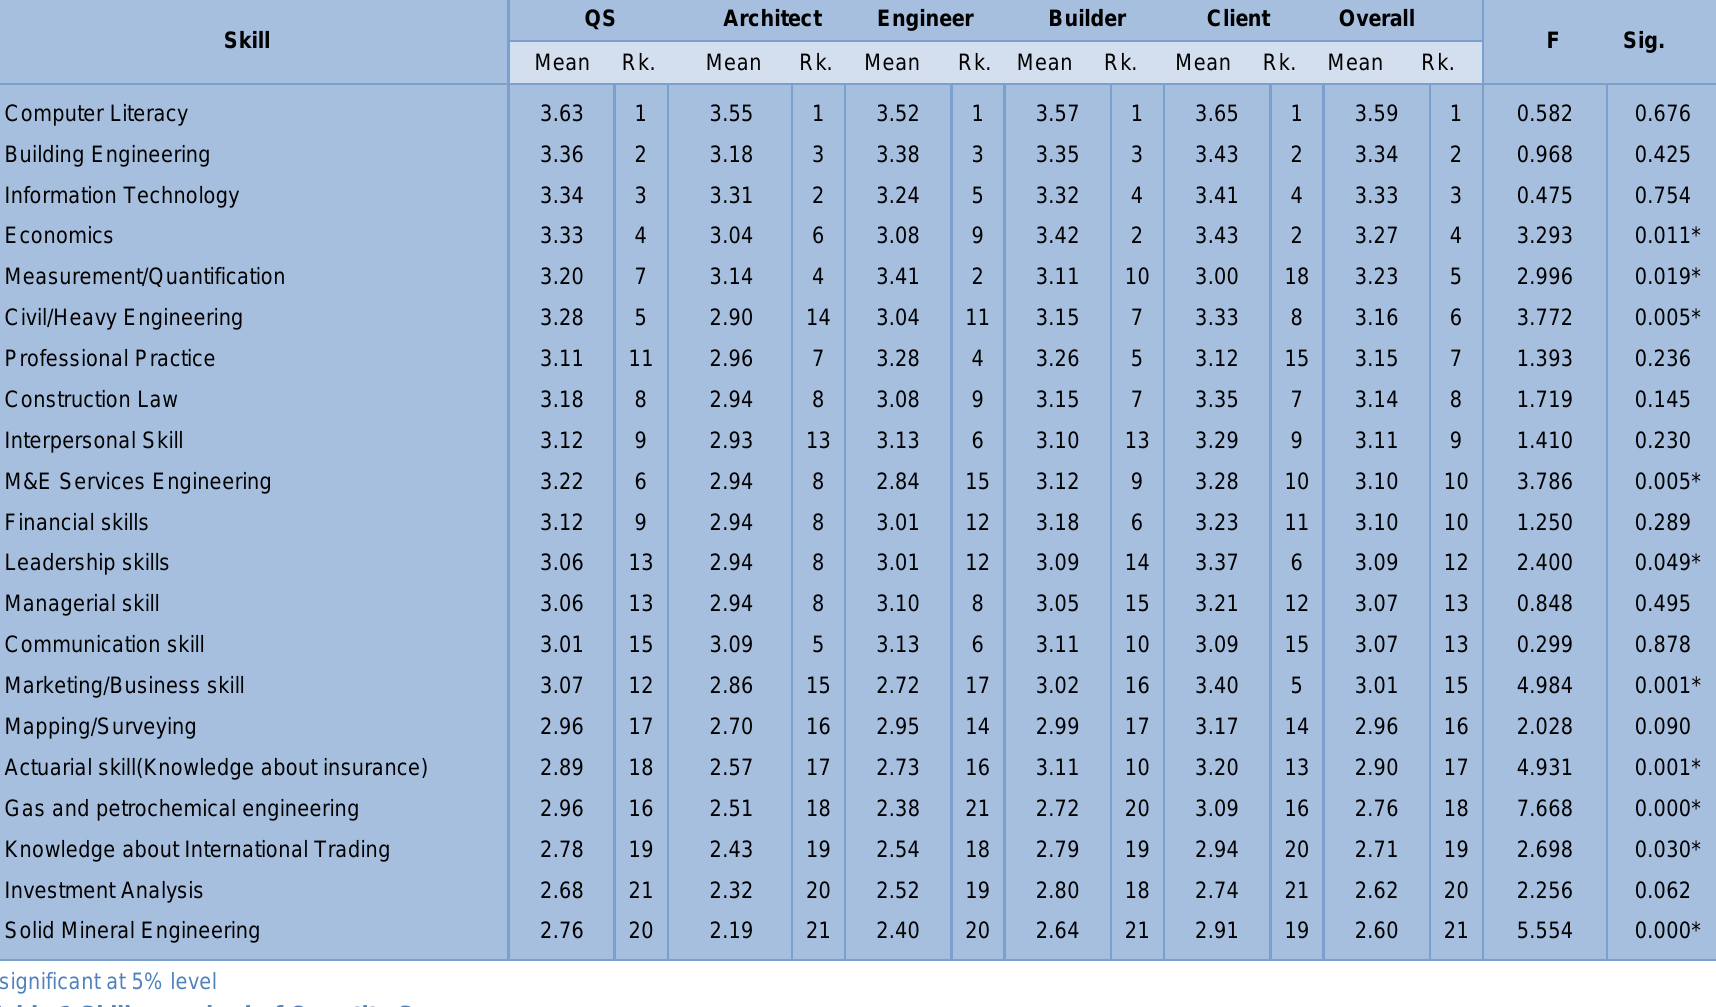
Table 1 Skills required of Quantity